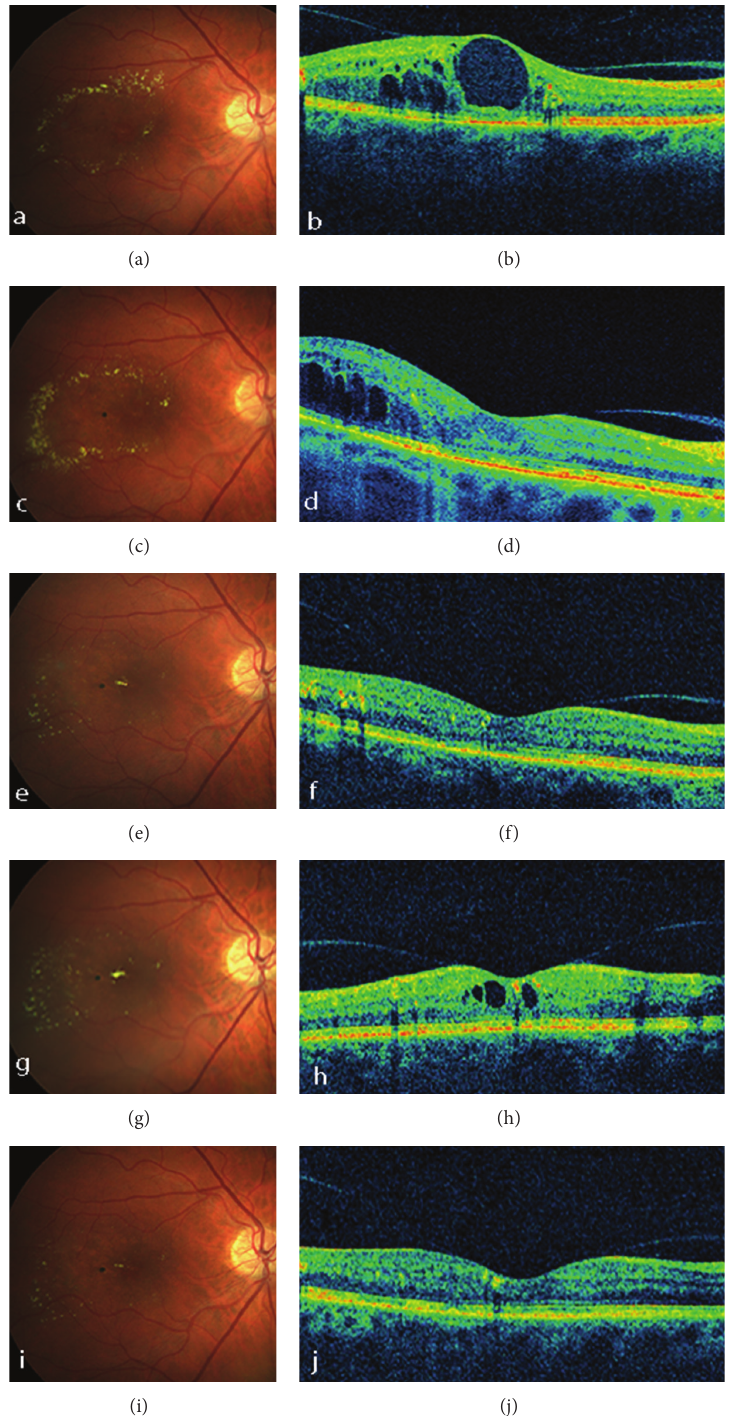
Figure 2: (a)-(b) After 3 monthly bevacizumab treatments, (c)-(d) after laser photogaoculation treatment, (e)-(f) after 4 months of aflibercept treatment, (g)-(h) after 4 months without treatment, and (i)-(j) after 4 weeks of aflibercept